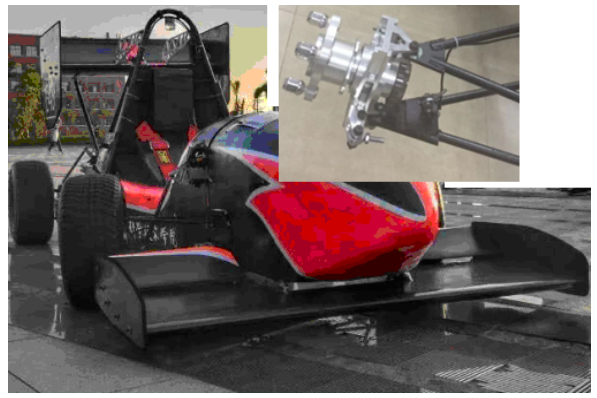
Figure 21. Assembly of integrated front uprights.